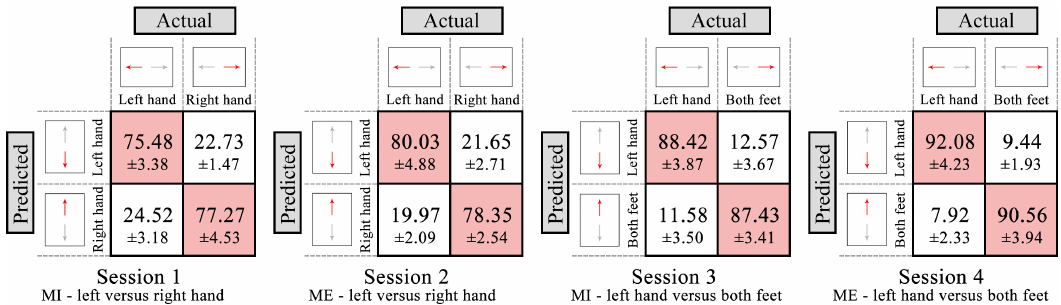
Figure 6. Confusion matrices (in %) for four sessions using S3 classification strategy in the decoder-training phase, averaged across all subjects. The numbers of each entry in the matrix represent the mean value and standard deviation across all subjects. The main diagonal entries stand for the correct classification, and the off-diagonal entries stand for the misclassification.